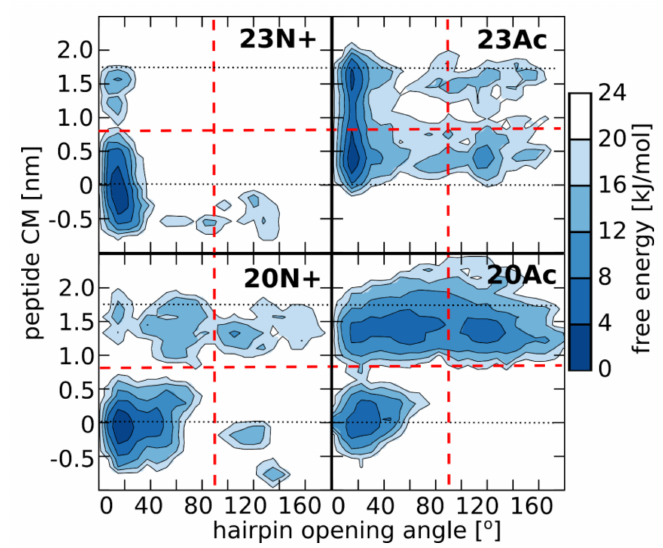
Figure 3. Free energy landscape for peptide configurations as a function of hairpin opening angle (defined as an angle between C alpha atoms of residues 1, 12, and 20—see the Supplementary Figure S3 for illustration), and peptide center of mass position along the membrane normal (with values of 0 and 1.8 denoted by dotted lines, corresponding to membrane center and surface, respectively). Red dashed lines divide peptide configurations into “open/closed” and “deep/surface” basins. Representative simulation frames for all basins are shown in the Supplementary Figure